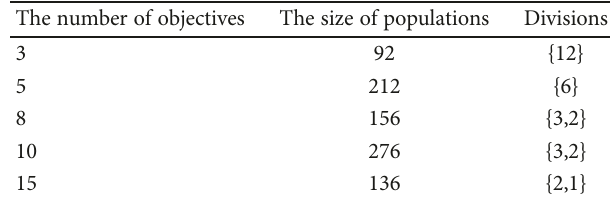
Table 7: Number of population size.